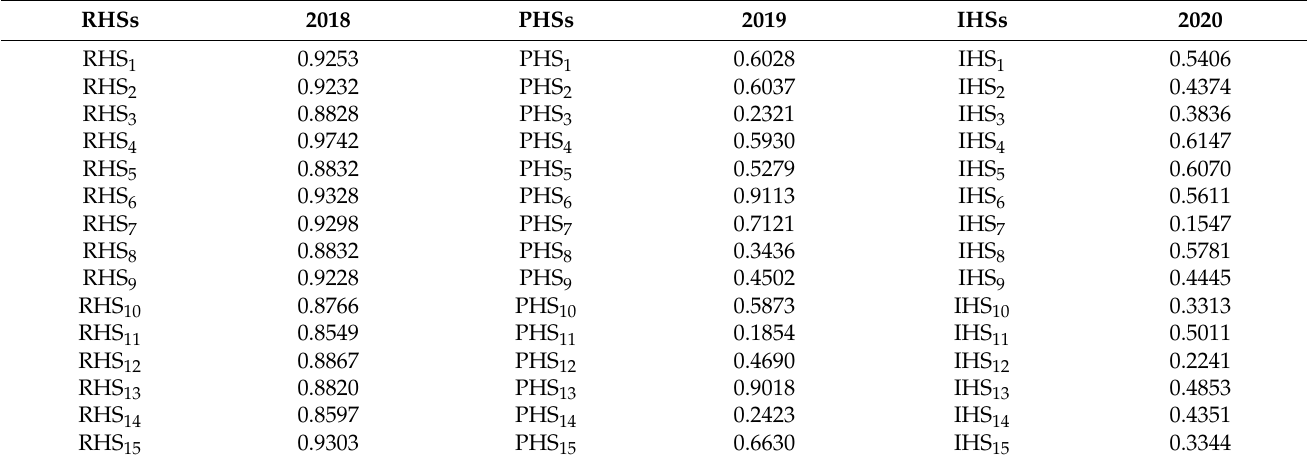
Table 3. The detection q value of different comprehensive index-layer drivers developed in the high-quality development of “three states” human settlements.